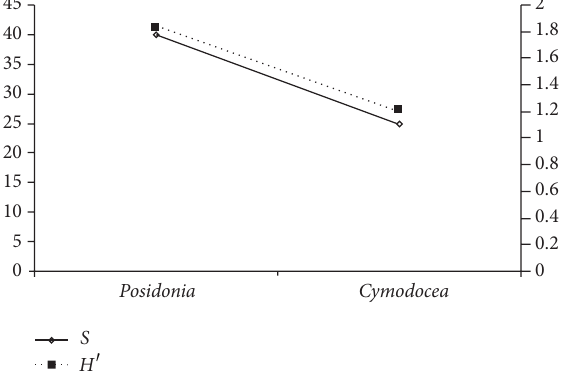
𝐻 󸀠 : Table 3). The same results were found by Mazzella et al. [30] in Adriatic Sea and by Turki [19] in Northern